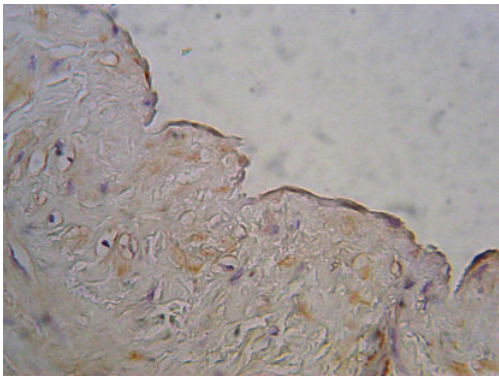
Figure 8: Expression of nNOS in the tunica media of varicose vein sample (magnification 400x, DAB).